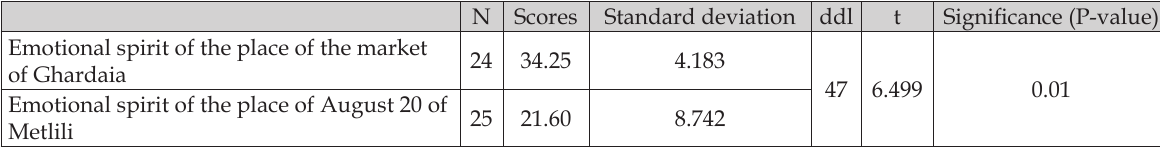
Table 9. Comparison between the means of the emotional spirits of the two public